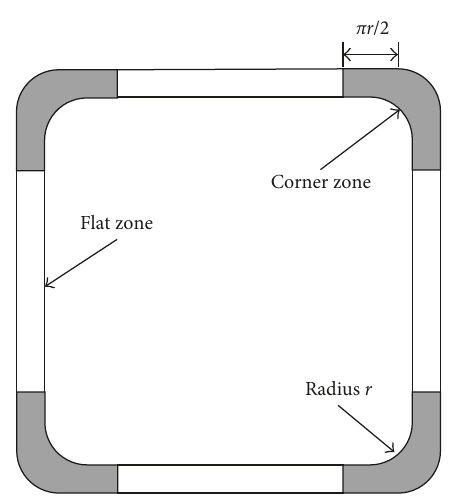
Figure 7: Flat and corner zones of the section of a cold-formed square steel tube.